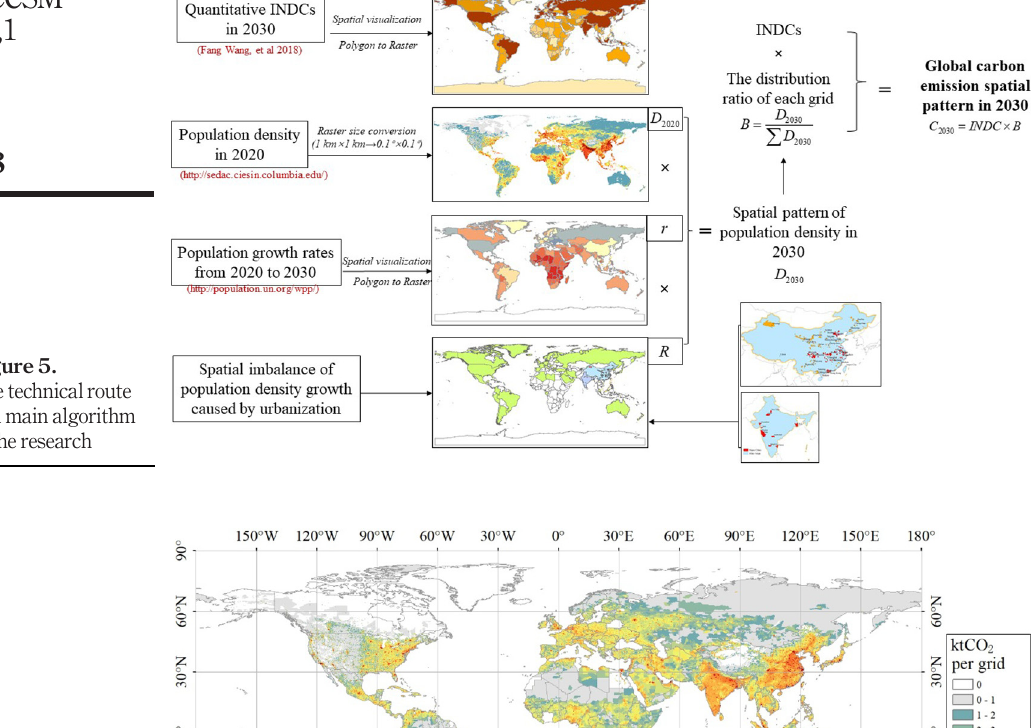
Figure 6. Spatial pattern of global carbon emissions under the unconditional INDC scenario in